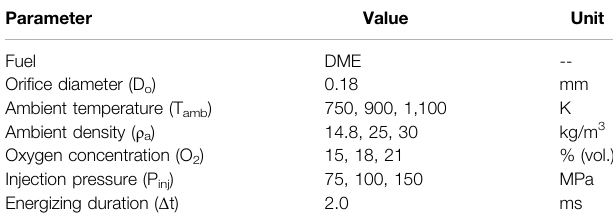
TABLE 1 | Summary of tested conditions.